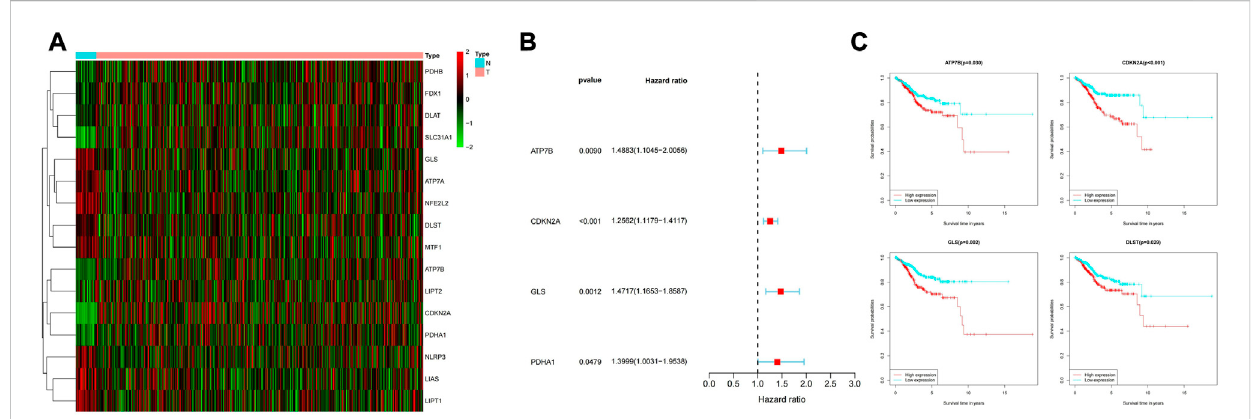
FIGURE 1 (A) Expression of cuproptosis-related genes in normal samples and samples from UCEC patients. (B) Normal samples and UCEC samples have differential expression of cuproptosis-related genes. (C) Relationship between expression of differentially expressed genes and survival